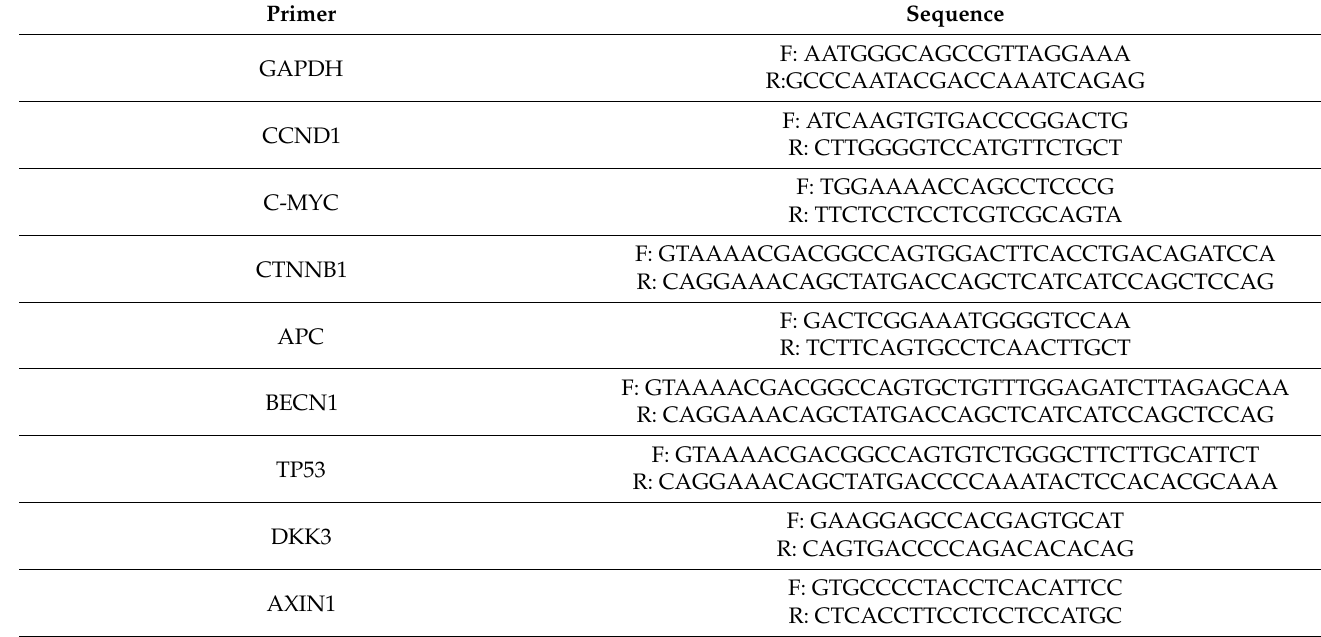
Table 1. Primer sequence used for relative mRNA expression